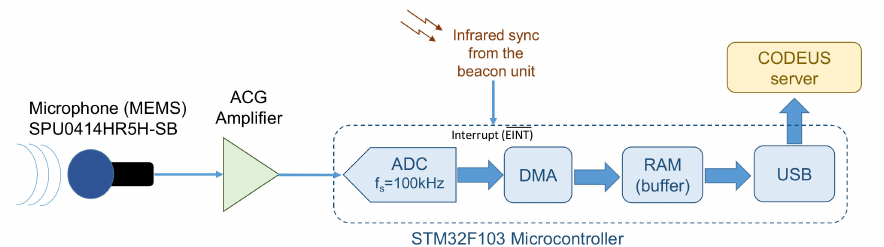
Figure 17. General block diagram of the receiving module included in the CODEUS online demon- strator